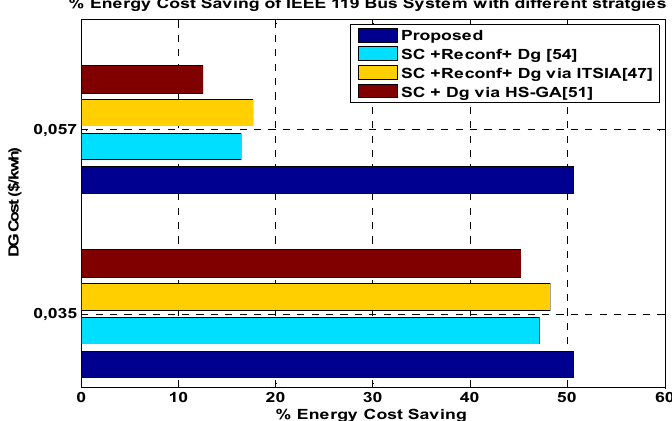
Figure 7. Comparison of % energy saving for the IEEE 119 system with different strategies of energy saving.